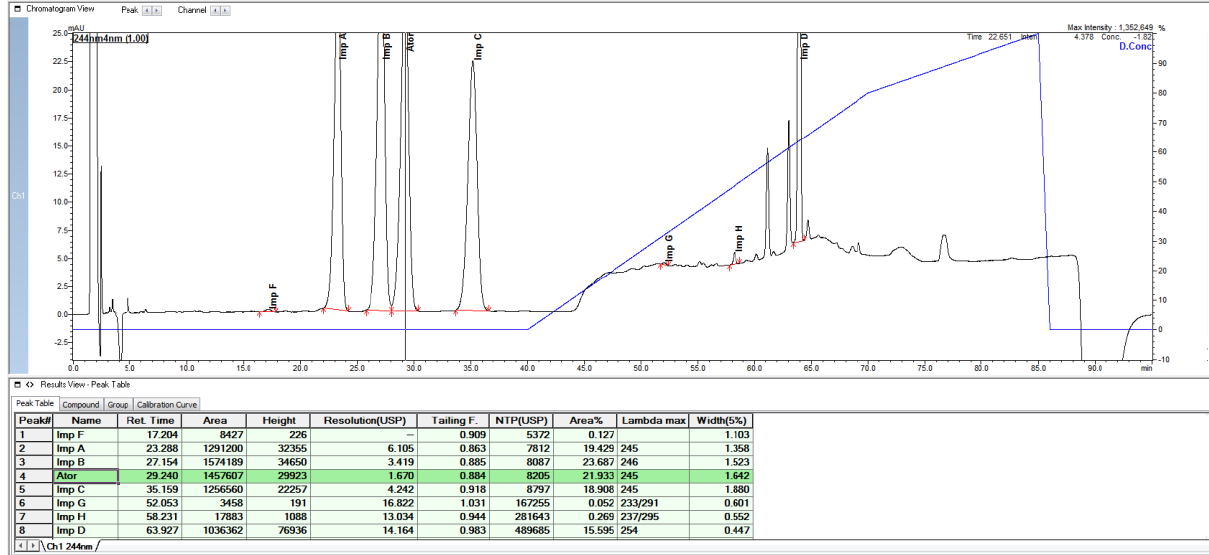
Figure 1. Chromatogram obtained using the method prescribed in European Pharmacopoeia (EP) 10 illustrating the elution order of atorvastatin impurities., obtained in our laboratory.